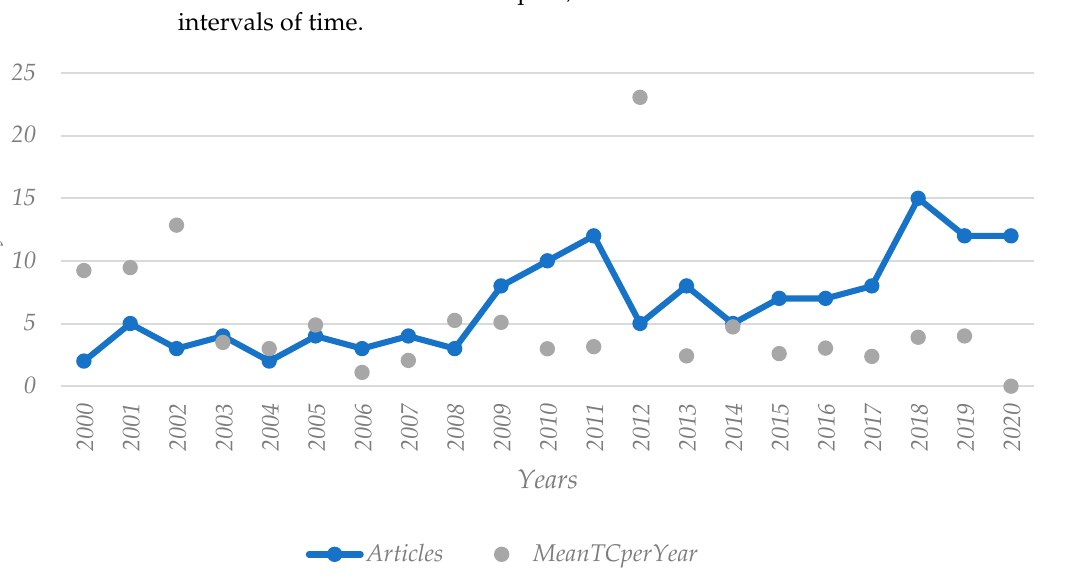
Figure 9. Number of articles and mean of total citations (TC) per year.